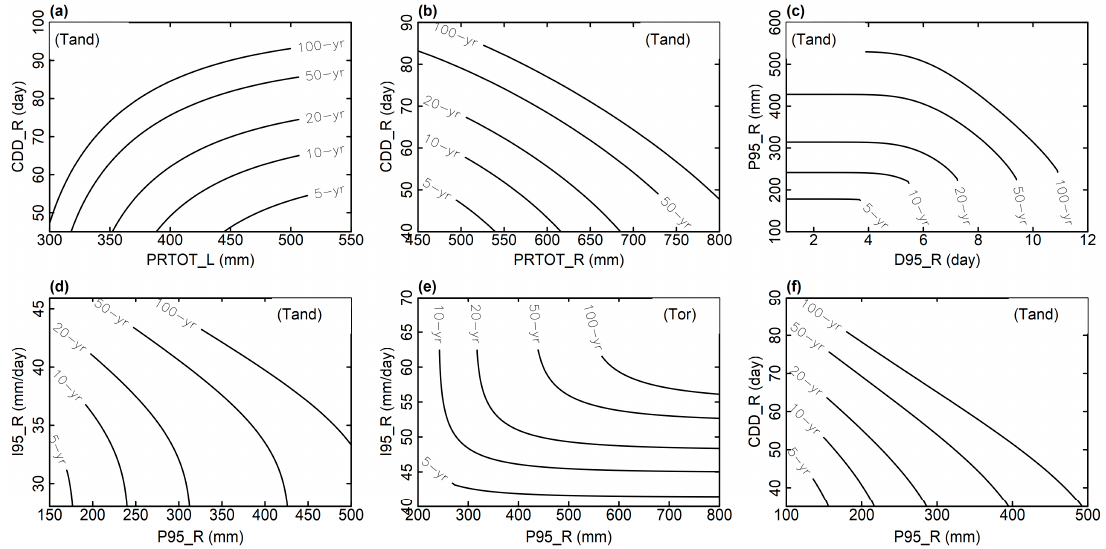
Figure 5. The joint return period of 5, 10, 20, 50, and 100 years under different combinations of six climate indicators: ( a ) “And” relation for combination of {PRTOT_L, CDD_R}, ( b ) “And” relation for combination of {PRTOT_R, CDD_R}, ( c ) “And” relation for combination of {D95_R, P95_R}, ( d )“And” relation for combination of {P95_R, I95_R}, ( e ) “Or” relation for combination of {P95_R, I95_R}, and ( f ) “And” relation for combination of {P95_R, CDD_R}.